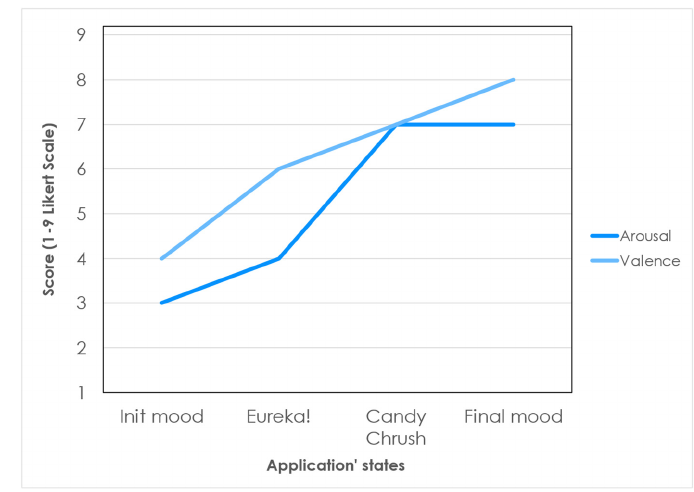
Figure 11. Chart of an individual case in the evolution of mood.